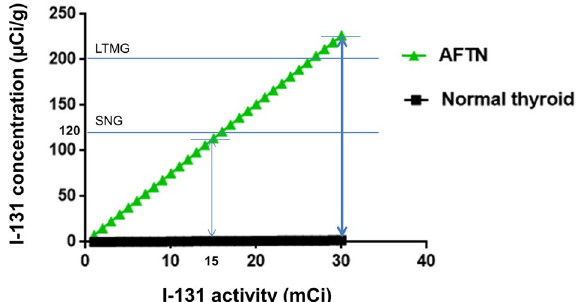
Fig. 3 Pre-therapeutic planning for I-131 activity. The target concentration of I-131 was plotted against I-131 activity for the AFTN and the contralateral normal thyroid tissue. The therapeutic windows for the AFTN and normal thyroid tissues are noted when 15 mCi (thin vertical double arrow) and 30 mCi (thick vertical double arrow) are applied. SNG refers to sporadic nontoxic nodular goiter, which was treated with an I-131 concentration of 120 µCi/g (3). LTMG stands for large toxic multi-nodular goiter, which was successfully treated with a target I-131 concentration of 200 µCi/g (14). AFTN autonomously functioning thyroid